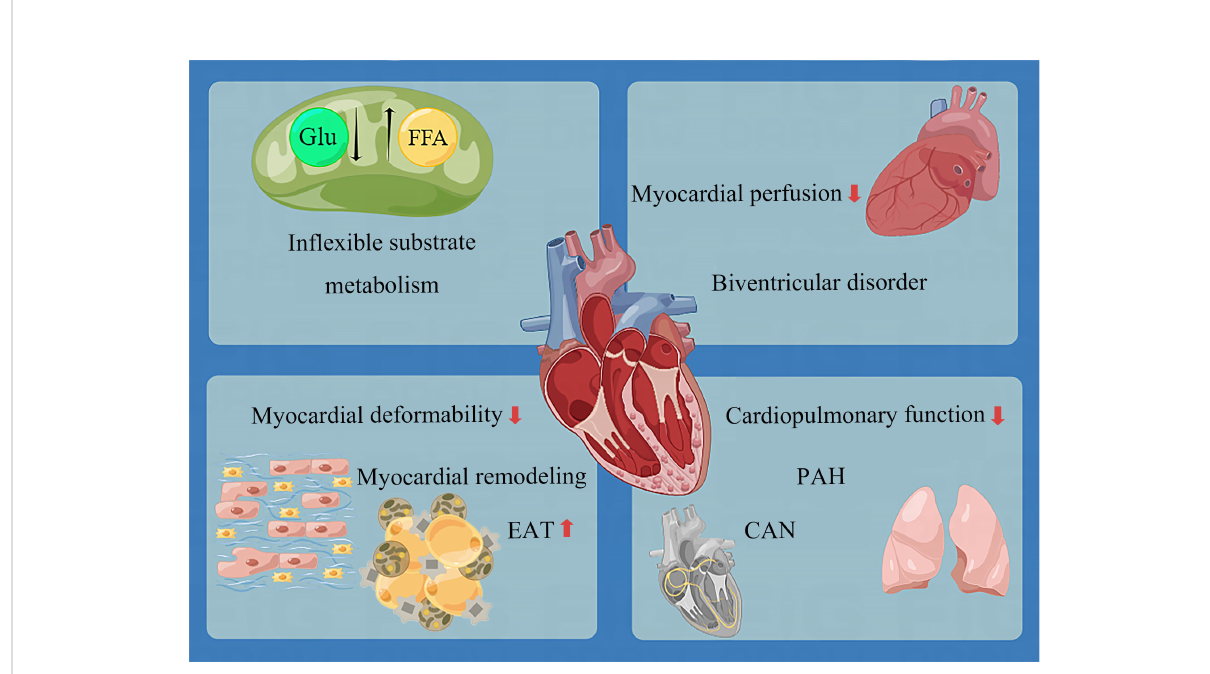
FIGURE 2 Overview of lesions in the development of DCM. CAN, cardiac autonomic neuropathy; EAT, epicardial adipose tissue; FFA, free fatty acid; Glu, glucose; PAH, pulmonary artery